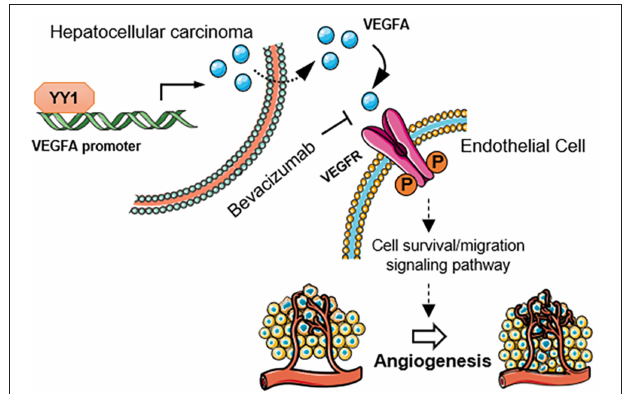
FIGURE 7 | Schematic diagram of the mechanism that YY1 promotes angiogenesis in HCC by activating VEGFA transcription. Secretion of VEGFA stimulated by YY1 promoted phosphorylation level of VEGFR2 in endothelial cells, which activated VEGFR2 associated angiogenesis signaling pathway.